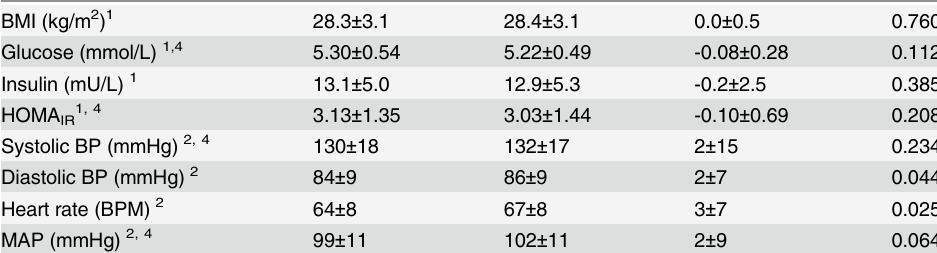
Table 3. Effect of 4-wk resveratrol intake on metabolic risk markers.